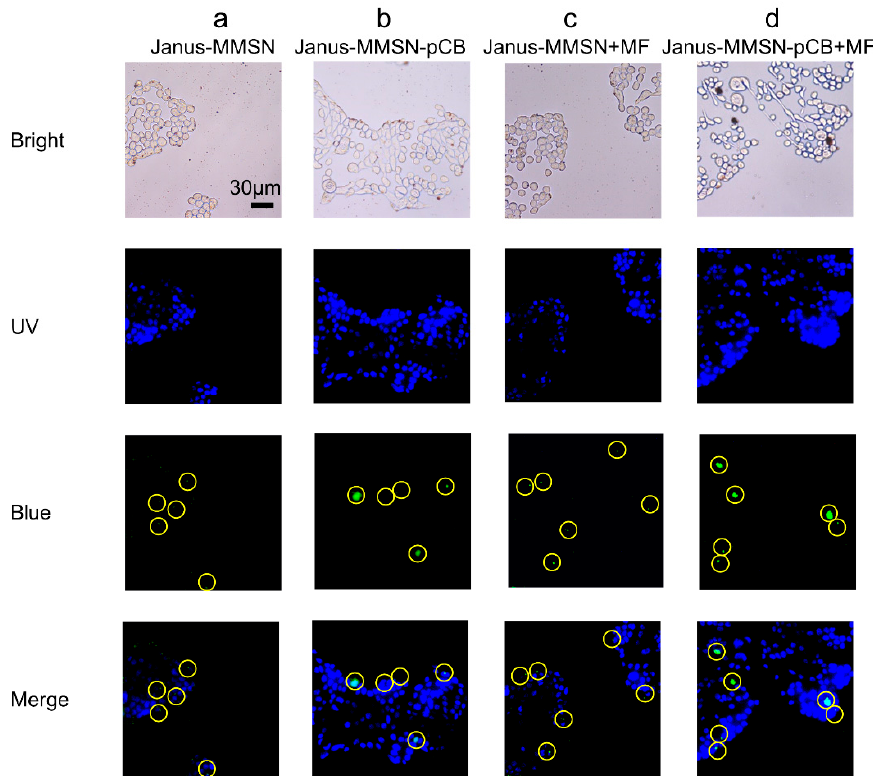
Figure 5. Cell imaging of Calu-3 cells cocultured with Janus-MMSN and Janus-MMSN-pCB for 4 h. ( a ) Janus-MMSN without magnetic driving; ( b ) Janus-MMSN-pCB without magnetic driving; ( c ) Janus-MMSN with magnetic driving; ( d ) Janus-MMSN-pCB with magnetic driving. Yellow dashed circles are used to highlight the green dots in these